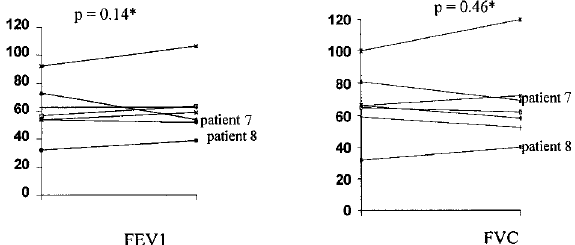
FIG. 1. Evolution of FEV1 and FVC. *Wilcoxon’s signed rank